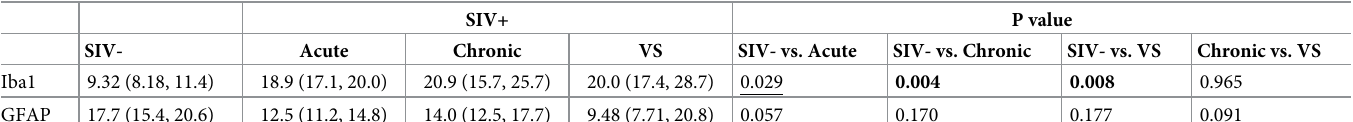
Table 2. Cell phenotypes in the brain of SIV+ NHPs.